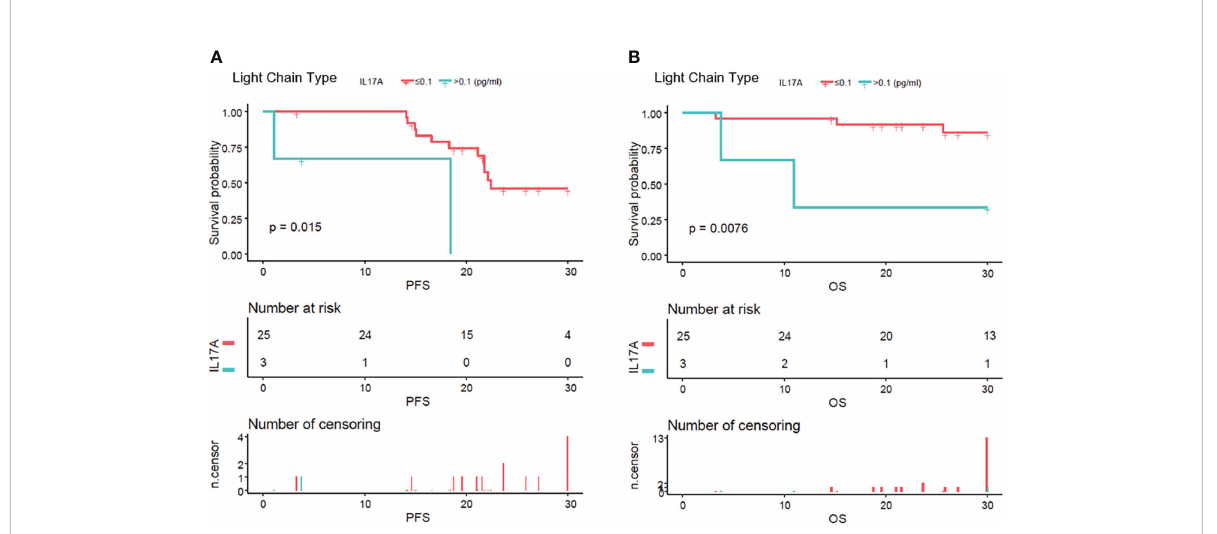
FIGURE 5 Kaplan – Meier curves of progression-free survival (PFS) and overall survival (OS) according to mean serum IL-17A levels in pure light chain type multiple myeloma patients. Compared with patients with serum IL-17A > 0.1 pg/ml, PFS (A) (p = 0.015) and OS (B) (p = 0.0076) were signi fi cantly lower in patients with serum IL-17A ≤ 0.1 pg/ml.